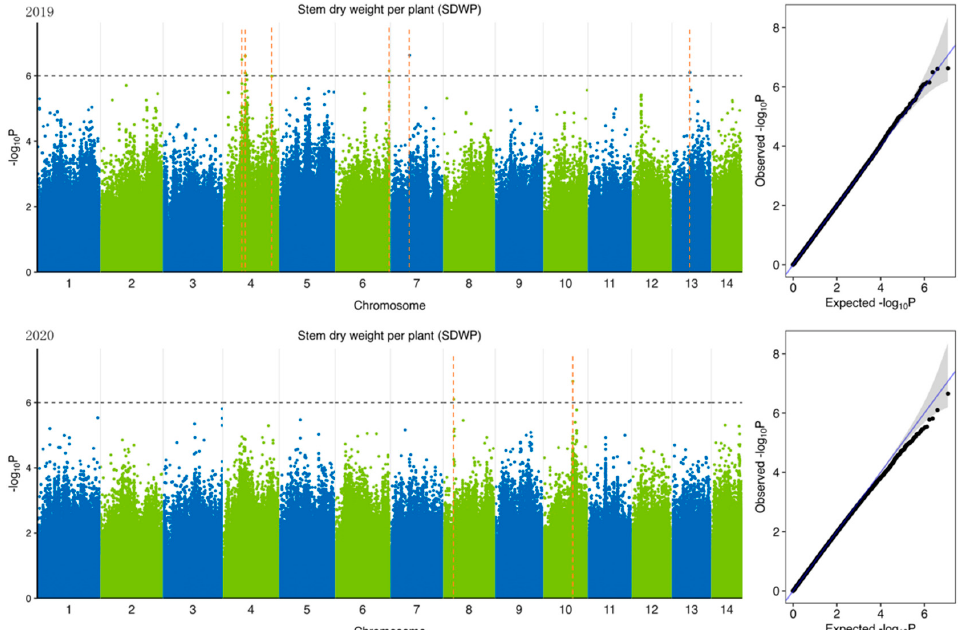
Figure 7. Manhattan plots of GWAS results for leaf dry weight per plant (LDWP) in 2019 and 2020. Notes: Blue and green dots represented SNP (single nucleotide polymorphism) sites on chromo- somes, respectively. When the value of − log 10 p was above 6 (gray line), the selected SNP site with significant aboriginality. Orange dotted lines represented the location of SNP loci.